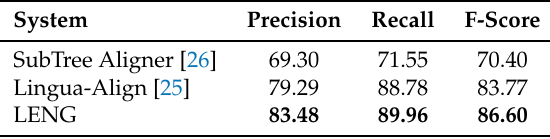
Table 1. Subtree alignment accuracy on English-Dutch gold standard. Best scores are set in